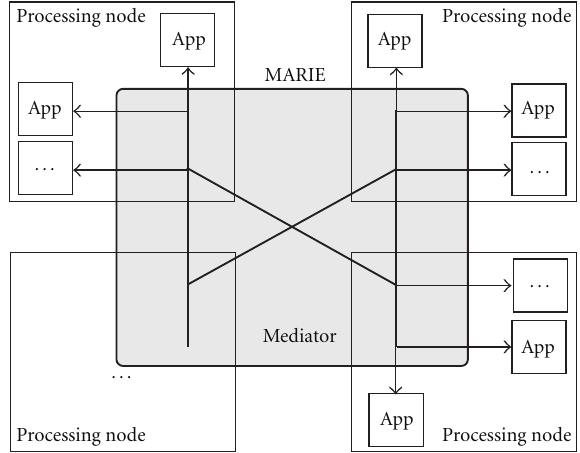
Figure 4: MARIE’s adaptation of the mediator pattern for dis- tributed system. (© (2004) IEEE) (reproduced from [38] with permission of Dr. Carle Cˆot´e and Dr. Franc¸ois